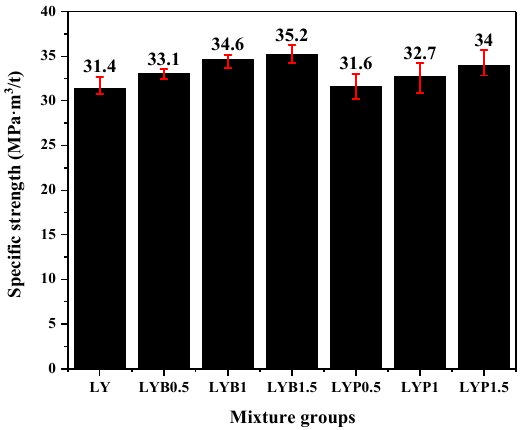
Figure 4. Specific strength of mixture groups.